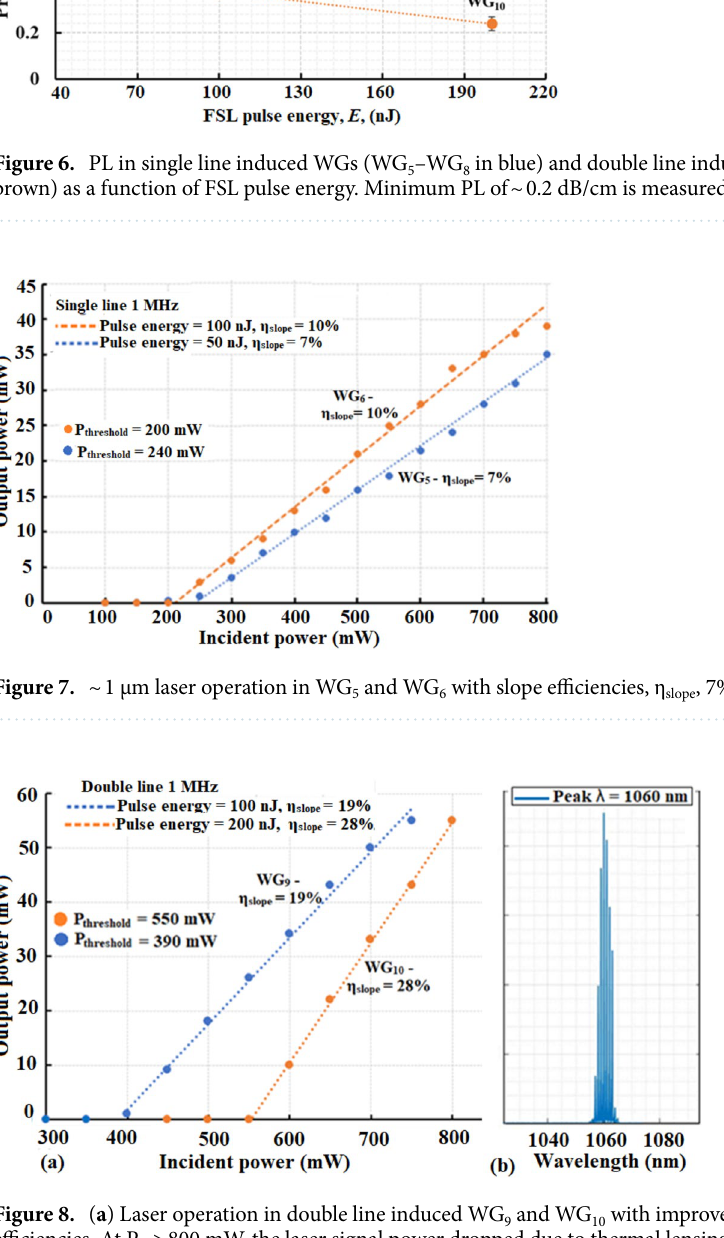
Figure 8. ( a ) Laser operation in double line induced WG 9 and WG 10 with improved 19% and 28% slope efficiencies. At P in > 800 mW, the laser signal power dropped due to thermal lensing within the WGs. ( b ) WG 10 laser operation at 1060 nm with a FWHM ~ 5